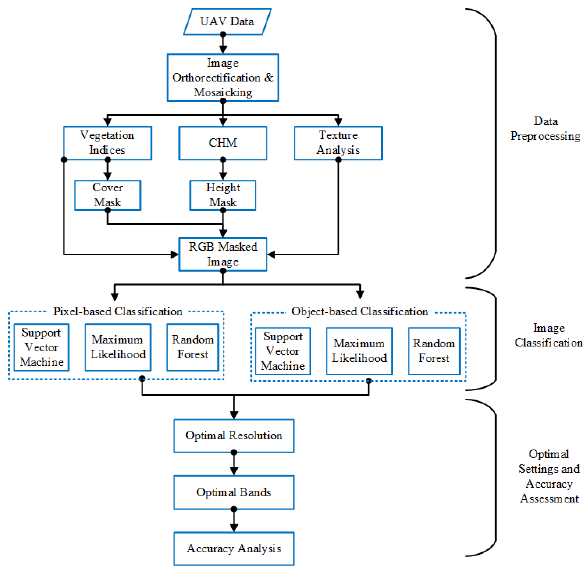
Figure 2 . The workflow of distinguishing wild parsnip Data pre-processing included image ortho-rectification, Digital Surface Model (DSM) and Digital Terrain Model (DTM)